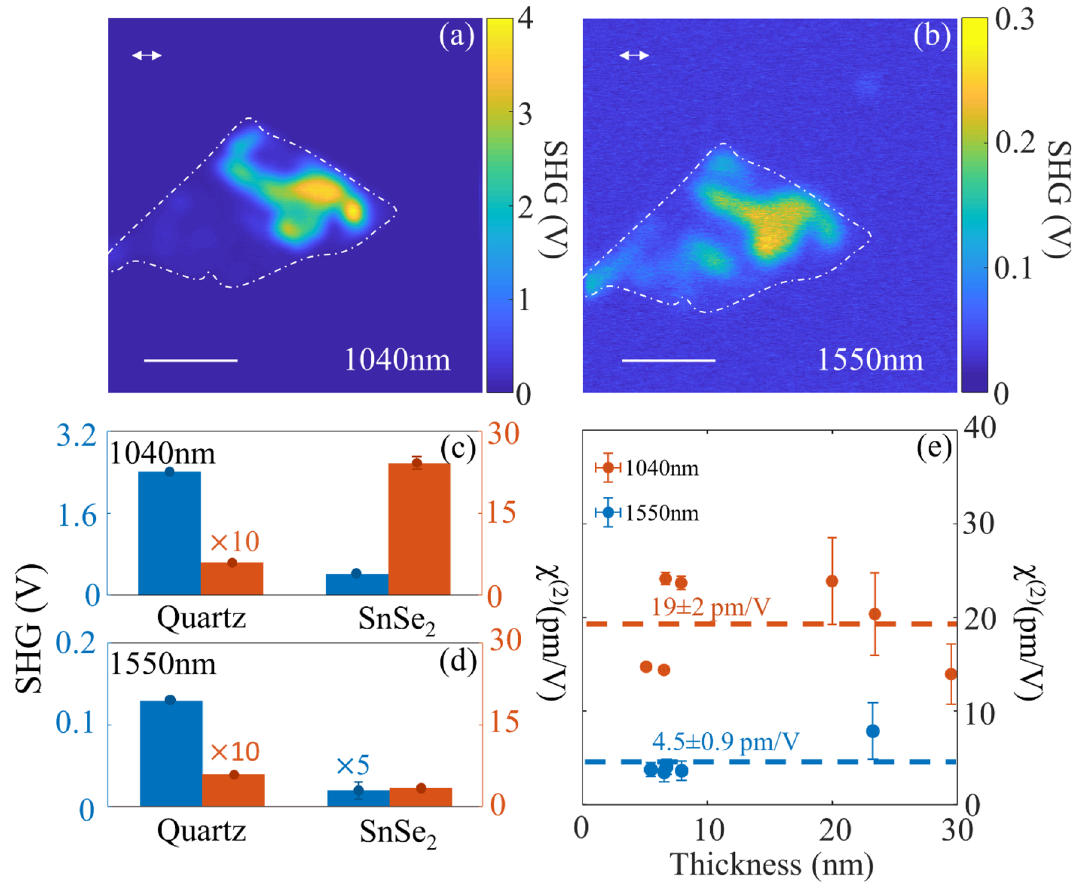
Figure 5. Wavelength dependent SHG from multilayer SnSe 2 . SHG images acquired at ( a ) 1040 nm, and ( b ) 1550 nm excitation wavelengths. The scale bar corresponds to 5 μm. Bar-charts comparing SHG signal (blue) and extracted nonlinear optical susceptibility (orange) for Quartz and SnSe2 for ( c ) 1040 nm, and ( d ) 1550 nm excitation wavelengths. ( e ) Thickness dependent nonlinear optical susceptibility for 1040 nm (orange) and 1550 nm (blue) excitation wavelength. The dashed lines indicate the average value. (Created in MATLAB v9.6, R2019a, https:// in. mathw orks.